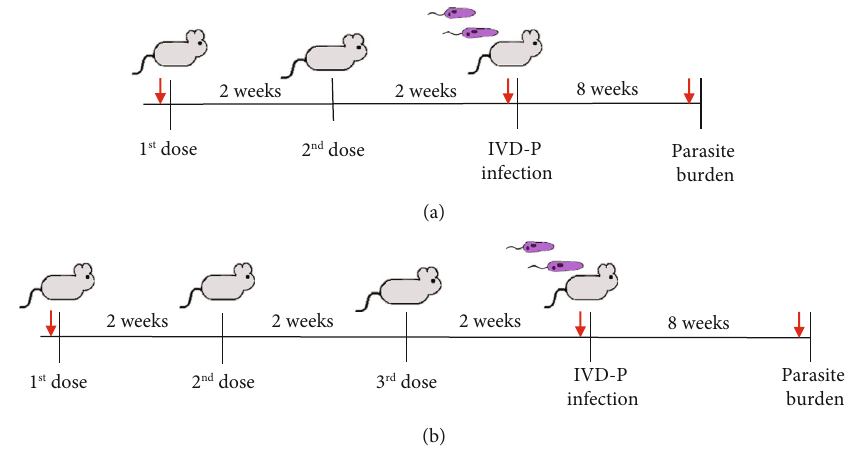
Figure 2: Immunization protocols of BALB/c mice with EVs released by LT-P or IVD-P L. amazonensis promastigotes. After 2 weeks of the last immunization, BALB/c mice were infected in the hind footpad with 1 × 10 6 IVD-P. (a) Protocol with 2 doses and (b) protocol with 3 doses. Red arrows represent blood collection (before the fi rst immunization, before the challenge with the parasites, and at the